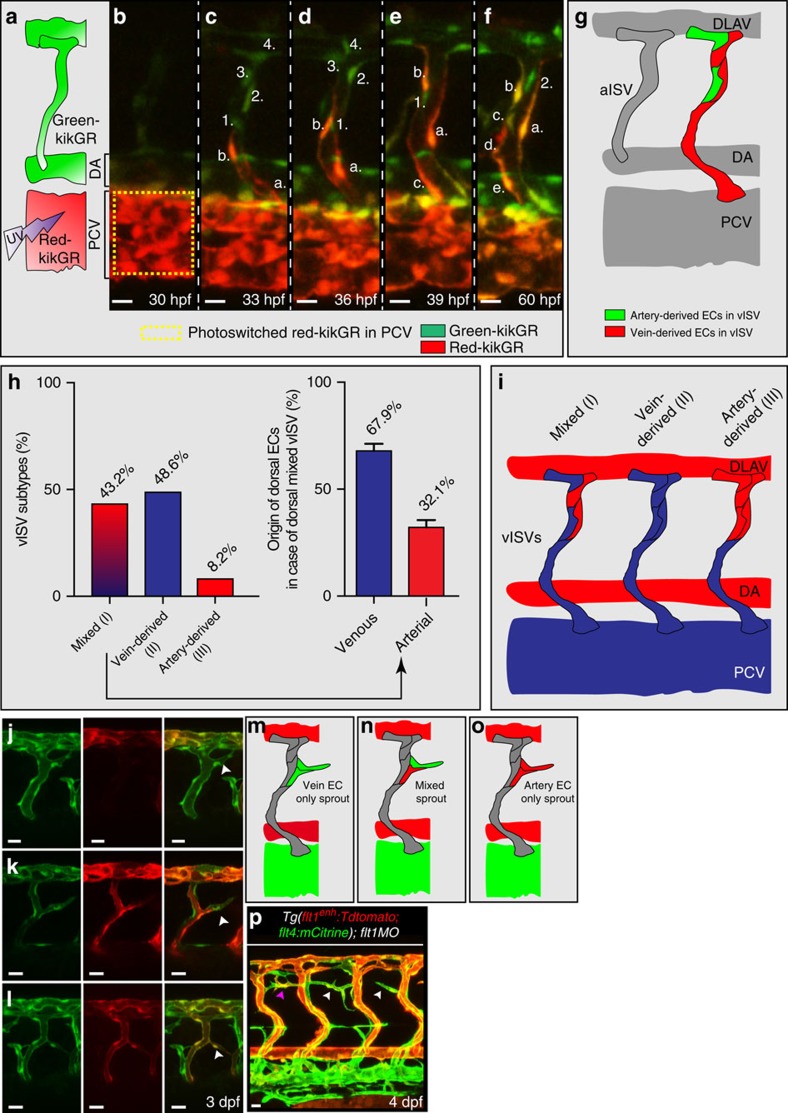
Arterial and venous-derived endothelial cells populate the dorsal part of venous ISV and contribute to sprouting upon loss of flt1.(a) Endothelial cell tracking in Tg(kdrl:nlsKikGR)hsc7 embryos. Photo-converted PCV-derived venous endothelial cells express red-kikGR. (b–f) Endothelial cell tracing during 30–60 hpf, showed that PCV-derived endothelium, indicated in red & labelled a,b,c,d,e, migrated along the ISV, from ventral to dorsal up to the most dorsal part of vISVs (cell labelled b). Pre-existing arterial endothelial cells in ISV, in green and labelled 1,2,3,4, shows artery-derived ECs in the dorsal part of vISVs (cell labelled 2) adjacent of PCV-derived EC (cell labelled b,a). (g) Schematic representation of the scenario imaged in b–f. (h) Left panel: Identity analysis of endothelial cells in the dorsal part of vISV revealed three different scenarios: (I) mixed, both arterial and venous-derived endothelium were present, (II) only vein-derived endothelium, (III) only artery-derived endothelium. (n=10 experiments & 6ISVs/embryo). Right panel: % of artery and vein-derived endothelium in the mixed population scenario. (i) Schematic representation of the three identity scenarios in dorsal part of vISV. Arterial derived EC in red, venous-derived EC in blue. (j–l) Ectopic sprouting scenarios in flt1 morphants in Tg(flt1enh:Tdtomato; flt4:mCitrine), n=6 embryos. (j) Ectopic venous sprout devoid of flt1enh expressing artery-derived EC (arrowhead). (k) Ectopic venous sprout (arrowhead) containing both arterial and venous-derived ECs; the flt1enh expressing artery-derived EC is juxtaposed to the venous-derived cell at the tip (arrowhead). (l) Ectopic venous sprout only containing flt1enh expressing artery-derived ECs; flt1enh (red) and flt4 (green) were expressed by the same cell which appears in yellow (arrowhead). (m–o) Schematic representation of the three ectopic venous sprouting scenarios. (p) Ectopic sprouting upon loss of flt1 in Tg(flt1enh:Tdtomato; flt4:mCitrine) (representative of 5 embryos). Flt1enh positive sprouts (pink arrowhead) and sprouts devoid of flt1enh (white arrowhead). MO, flt1 morpholino, 1ng. aISV, arterial intersegmental vessel; DA, dorsal aorta; DLAV, dorsal longitudinal anastomotic vessel; PCV, posterior cardinal vein; vISV, venous intersegmental vessel. Scale bar, 20 μm in j–l, 10 μm in b–f,p.